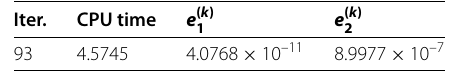
Table 1 Iteration number, CPU time, and values of e ( k ) ω 0.25 1 1.5 CPU time